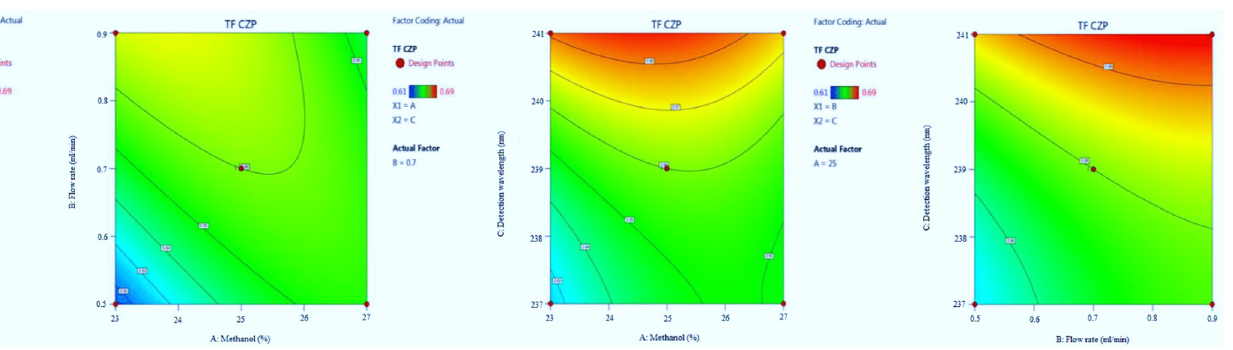
Figure 8. Contour plots for CZP tailing factor time in terms of AB, AC, and BC.